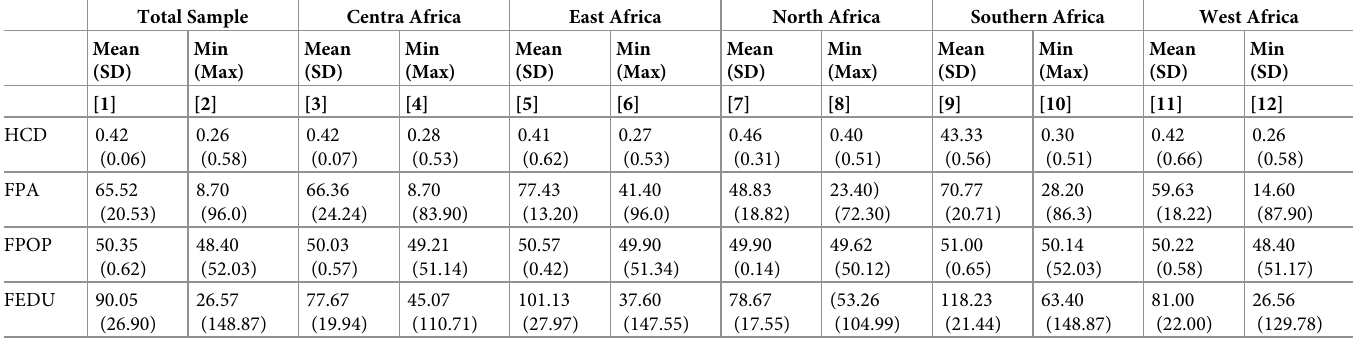
Table 2. Descriptive statistics.